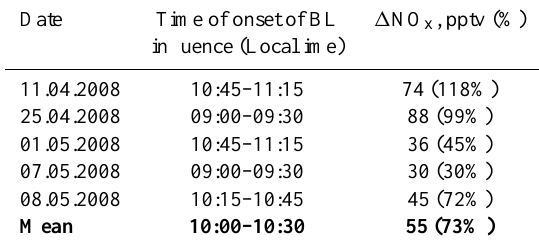
Table 2. Estimation of the timing of the onset of a BL influence at the summit of MBO using the chairlift sounding and NO x data. 1 NO x values indicate the difference between the 3h average NO x before and after the time listed in the middle column.